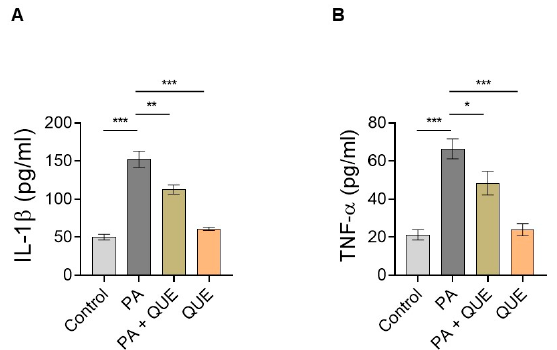
Figure 5. Effect of QUE against the release of PA-induced, pro-inflammatory cytokines in H9c2 cells. ( A ) IL-1 β and ( B ) TNF- α levels in culture supernatant of H9c2 cardiomyocytes treated with vehicle (control), PA (200 µM), QUE (50 nM) for 2 h and then PA for 24 h, and QUE alone (50 nM) for 24 h. The levels of IL-1 β and TNF- α , as specific pro-inflammatory markers, were expressed as pg/mL. Data are reported as the mean ± SEM of six separate experiments. Significant differences were detected by one-way ANOVA and Newman–Keuls multiple comparison test, p < 0.05 (*); p < 0.01 (**); p < 0.001 (***).